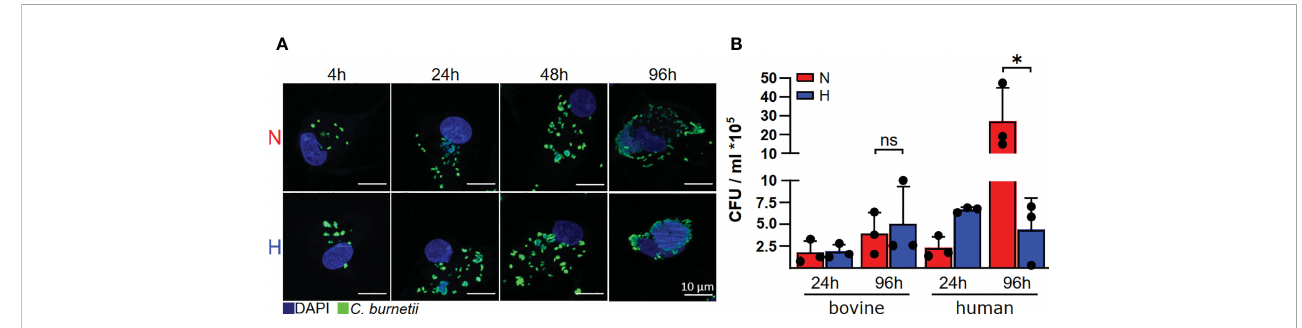
FIGURE 3 C. burnetii replication is inhibited by human, but not by bovine macrophages. (A) Bovine macrophages were infected with C. burnetii NMII for the time periods indicated under normoxic (N) or hypoxic (H) conditions. The cells were fi xed and stained with DAPI and an anti- C. burnetii antibody. Representative immuno fl uorescence micrographs from three independent experiments with similar results are shown. (B) Human macrophages from three different donors and three independent bovine macrophage preparations from two bovine donor animals were infected with C. burnetii NMII for 24 and 96 hours under normoxic (N) or hypoxic (H) conditions. Bacterial counts were determined by counting colony forming units (CFU). Unpaired t- test or Mann-Whitney test, n=3. *p<0.05, ns=p>0.05.